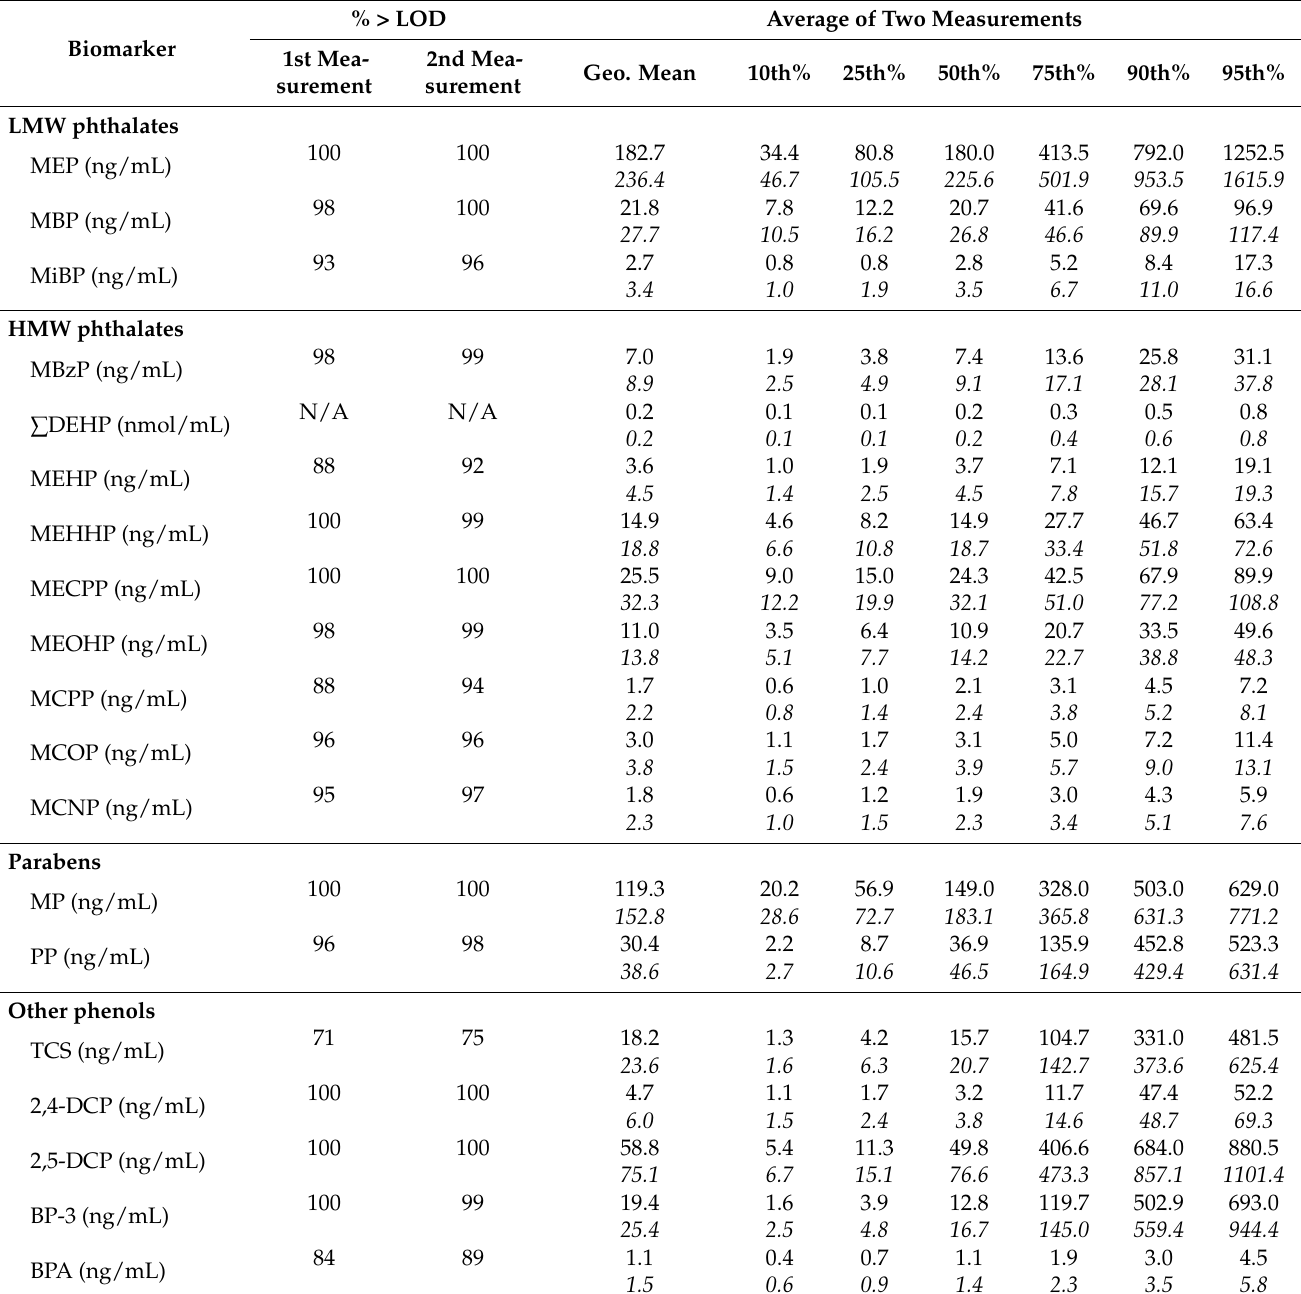
Table 2. Distribution of uncorrected and specific-gravity-corrected (italics) biomarker concentrations in maternal urine collected at two time points during pregnancy ( N =